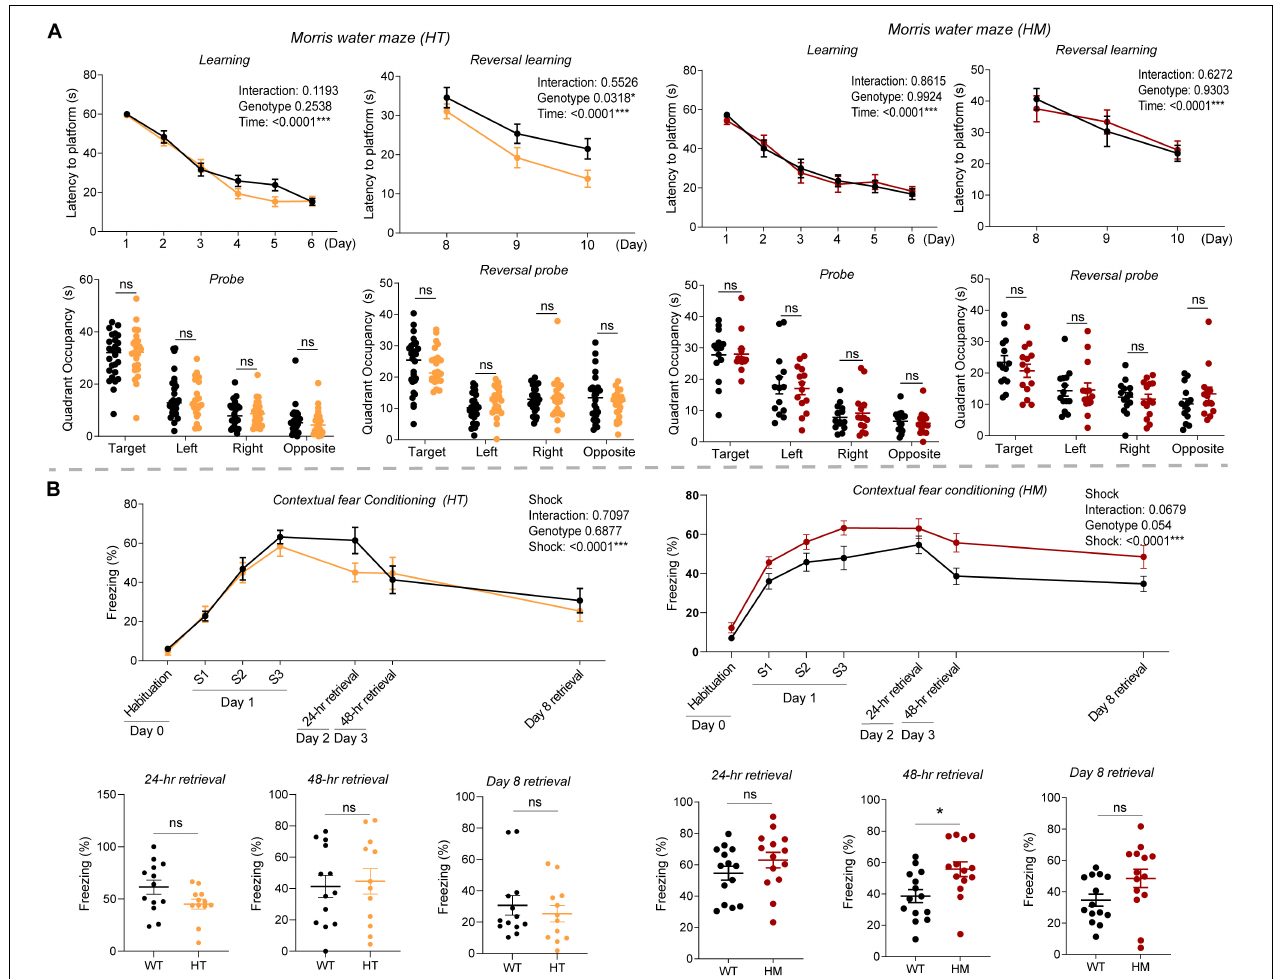
FIGURE 3 | Slc6a20a deficiency in mice moderately enhances spatial and fear memory. (A) Slc6a20a + / − and Slc6a20a − / − mice (3–6 months) show normal levels of spatial memory acquisition and retrieval (probe test) during the initial phase of the Morris water maze test, whereas Slc6a20a + / − but not Slc6a20a − / − mice show enhanced spatial memory acquisition but not retrieval during the reversal phase of the test. ( n = 26 mice [WT for HT], 23 [HT], 14 [WT for HM],14 [HM], two-way RM-ANOVA [latency to platform] and Student’s t -test [quadrant occupancy]). (B) Slc6a20a + / − and Slc6a20a − / − mice (3–6 months) show differential levels of fear memory acquisition (day 1) and retrieval (probe tests; days 2, 3, and 8) in the contextual fear conditioning test. ( n = 13 mice [WT for HT], 12 [HT], 14 [WT for HM], 14 [HM], two-way RM-ANOVA [acquisition] and Student’s t -test [retrievals]). Statistical significance and p values in the graphs; * p < 0.05, *** p < 0.001, ns,